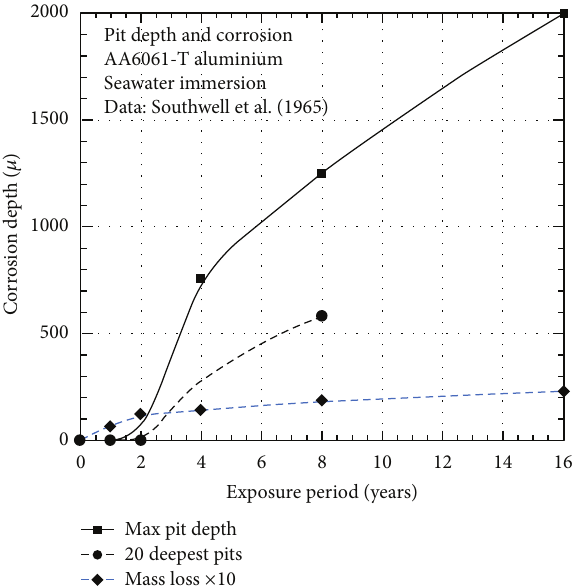
Figure 11: Data and fitted trends for AA6061-T exposed to seawater immersion conditions in the PCZ. The changeover to mode 2 occurs at about 3 years of exposure. Data from Southwell et al. [2].